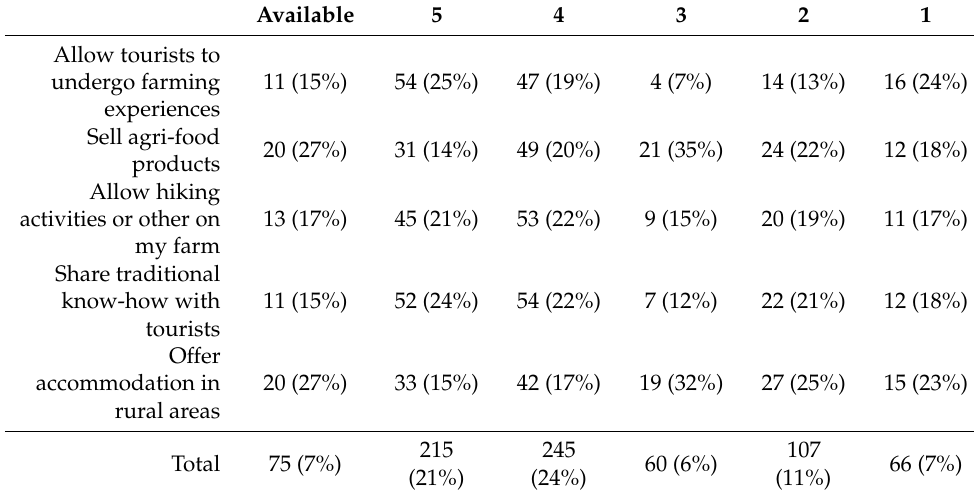
Table 6. Ability to offer agritourism activities (nº and